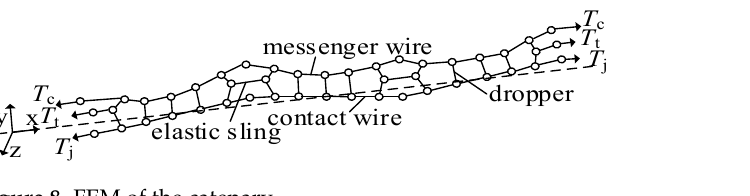
Figure 8. FEM of the catenary.